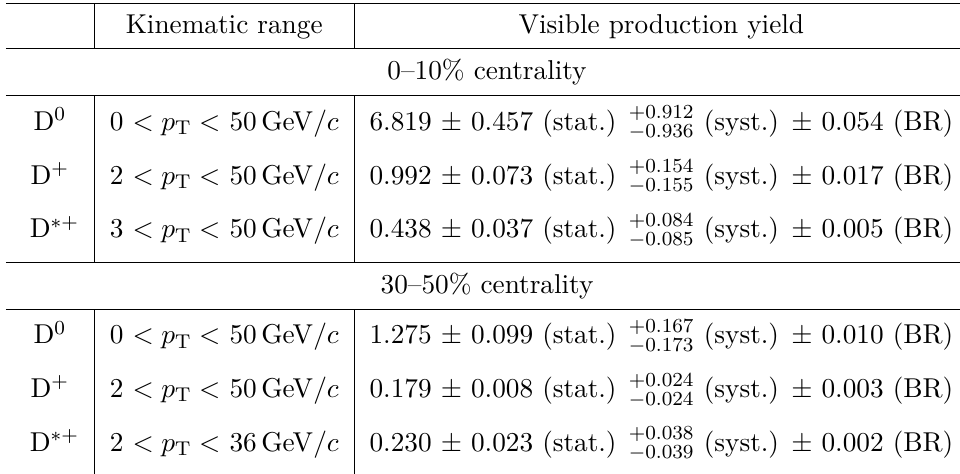
Table 3 . Visible production yield of prompt D 0 , D + , and D ∗ + mesons in | y | < 0.5 in the 0–10% and 30–50% centrality classes of Pb–Pb collisions at